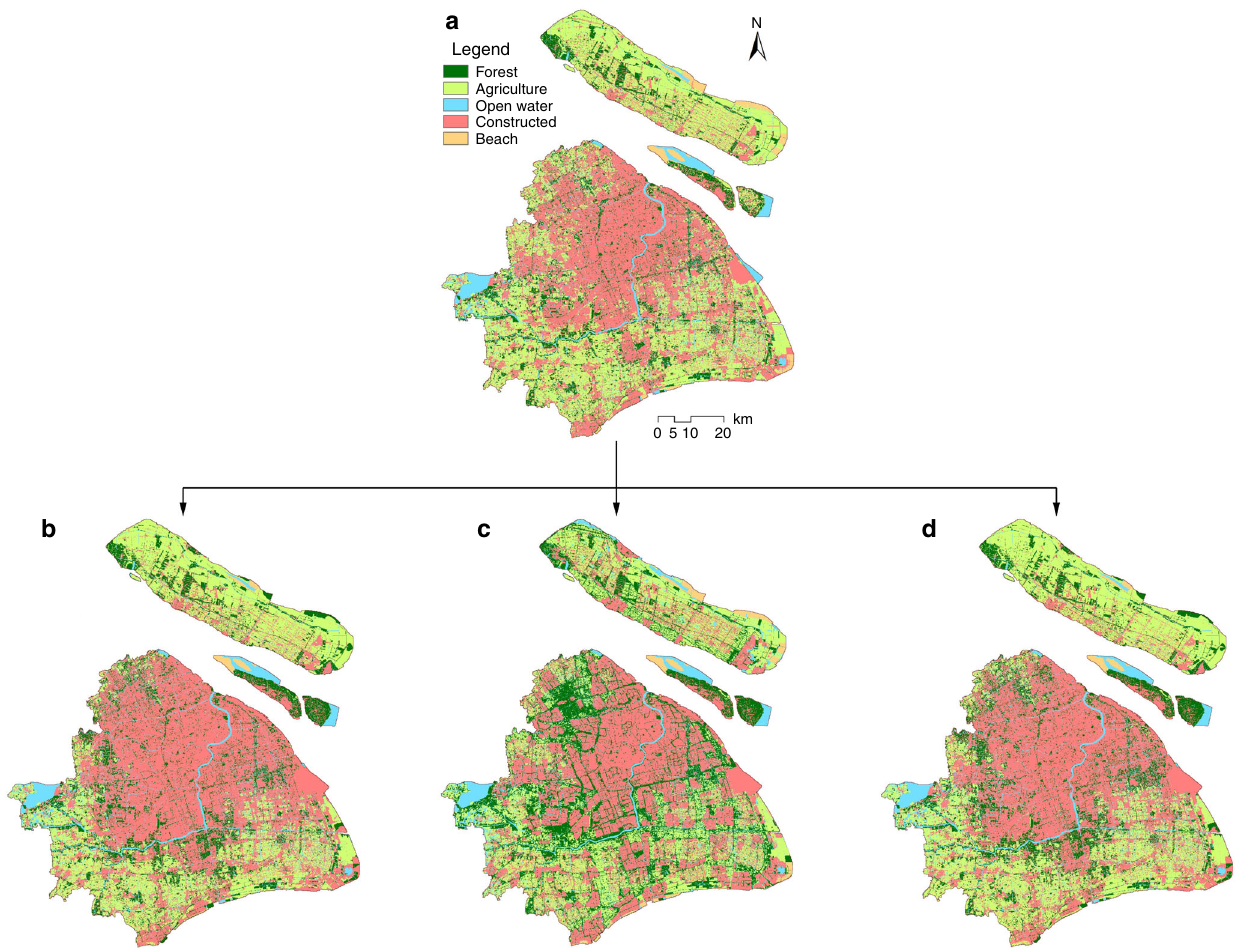
Fig. 4 Planning scenarios under different environmental and development policies for Shanghai. a Baseline scenario using current LULC with ERAs in 2014 (S1). b Development scenario for 2040 with no ERP and no policy constraints (S2). c Future ERP scenario for 2040 representing planned expansion of ERAs by 501 km 2 (S3). d Planning scenario for 2040 where existing ecological protection policies are implemented, except ERP. The maps in this fi gure were made by the author in ArcGIS software for use in this